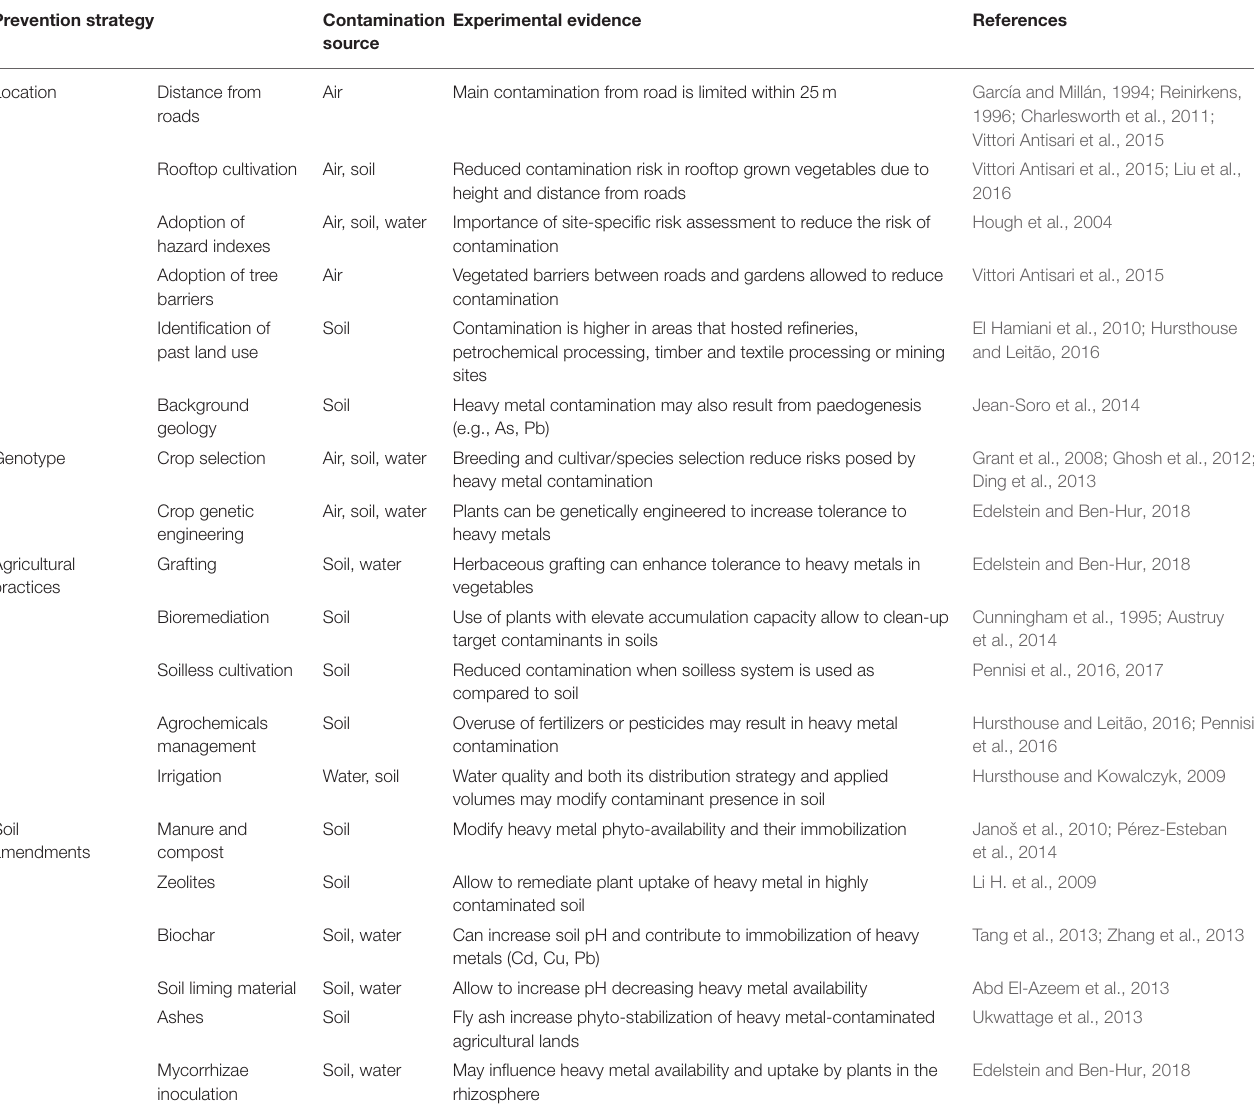
TABLE 3 | Strategies for reduced contamination risk in urban grown